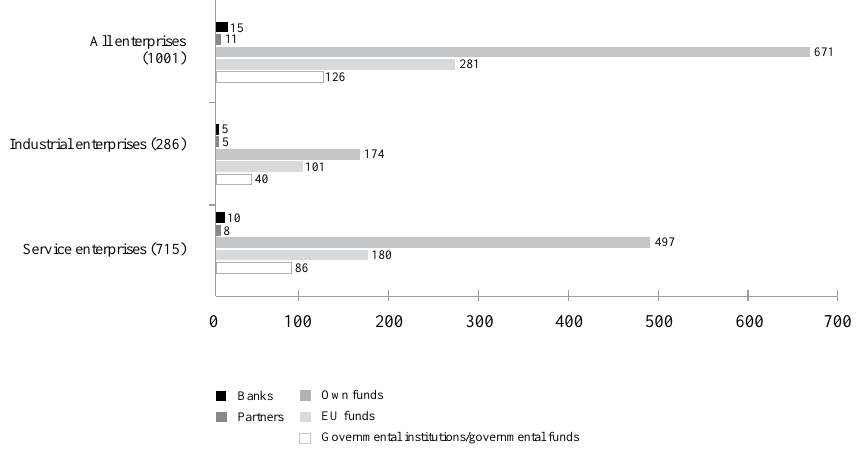
fig. 12. Financial sources of new technologies